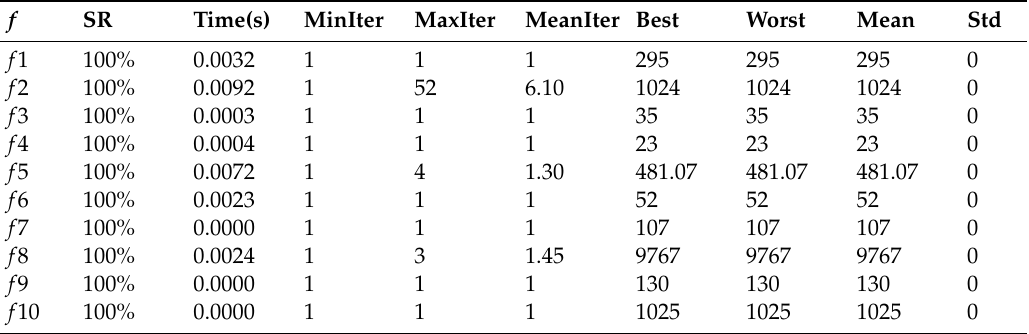
Table 5. The experimental results of 10 standard low-dimensional 0-1 KP instances obtained by